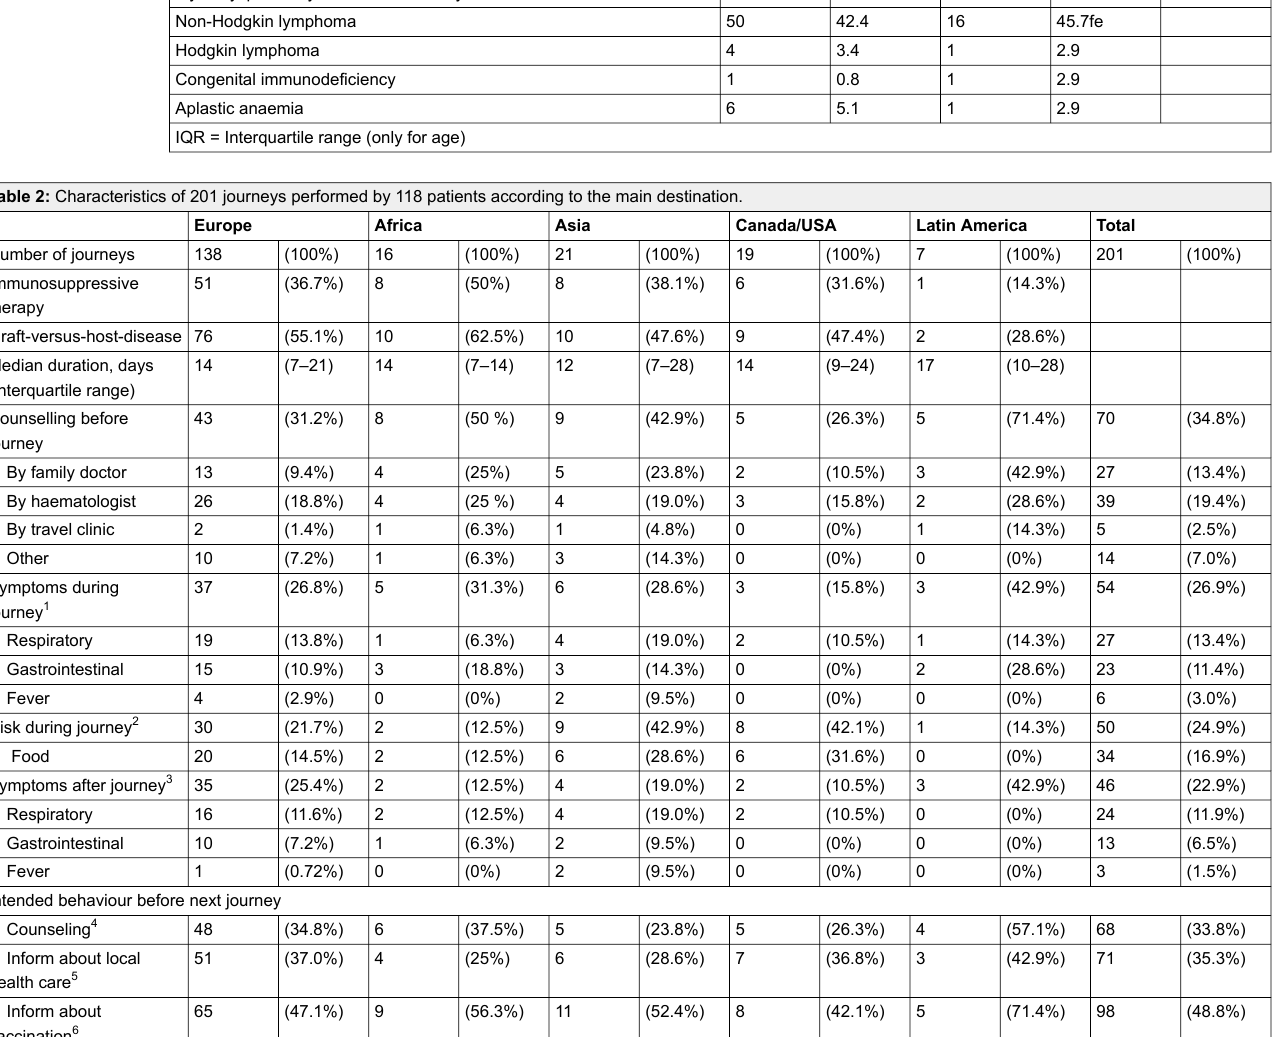
Travelers (n = 118)